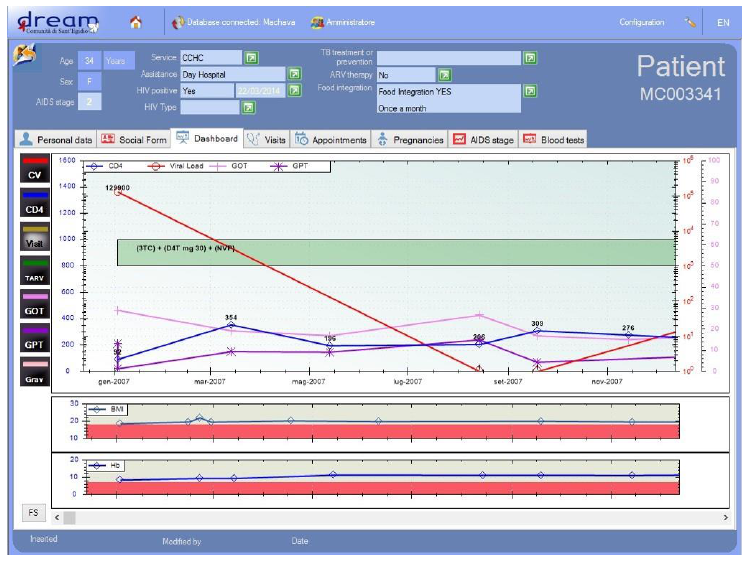
Figure 5. Electronic medical